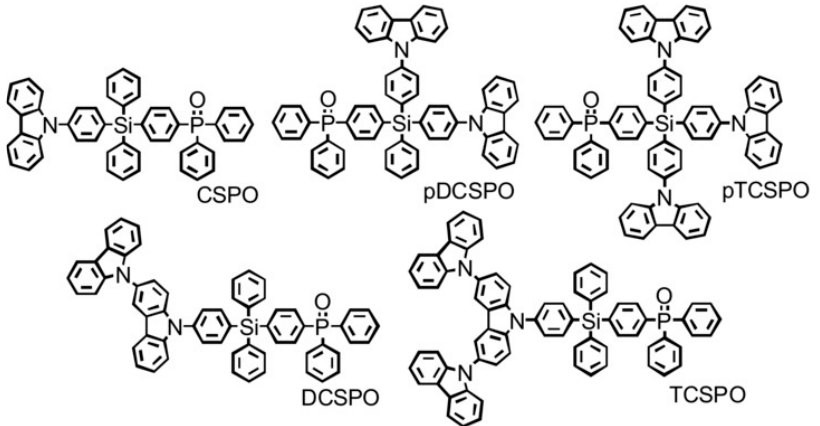
Figure 16. Chemical structures of five tetra-arylsilane based host materials [97]. Copyright 2012, Wiley-VCH.